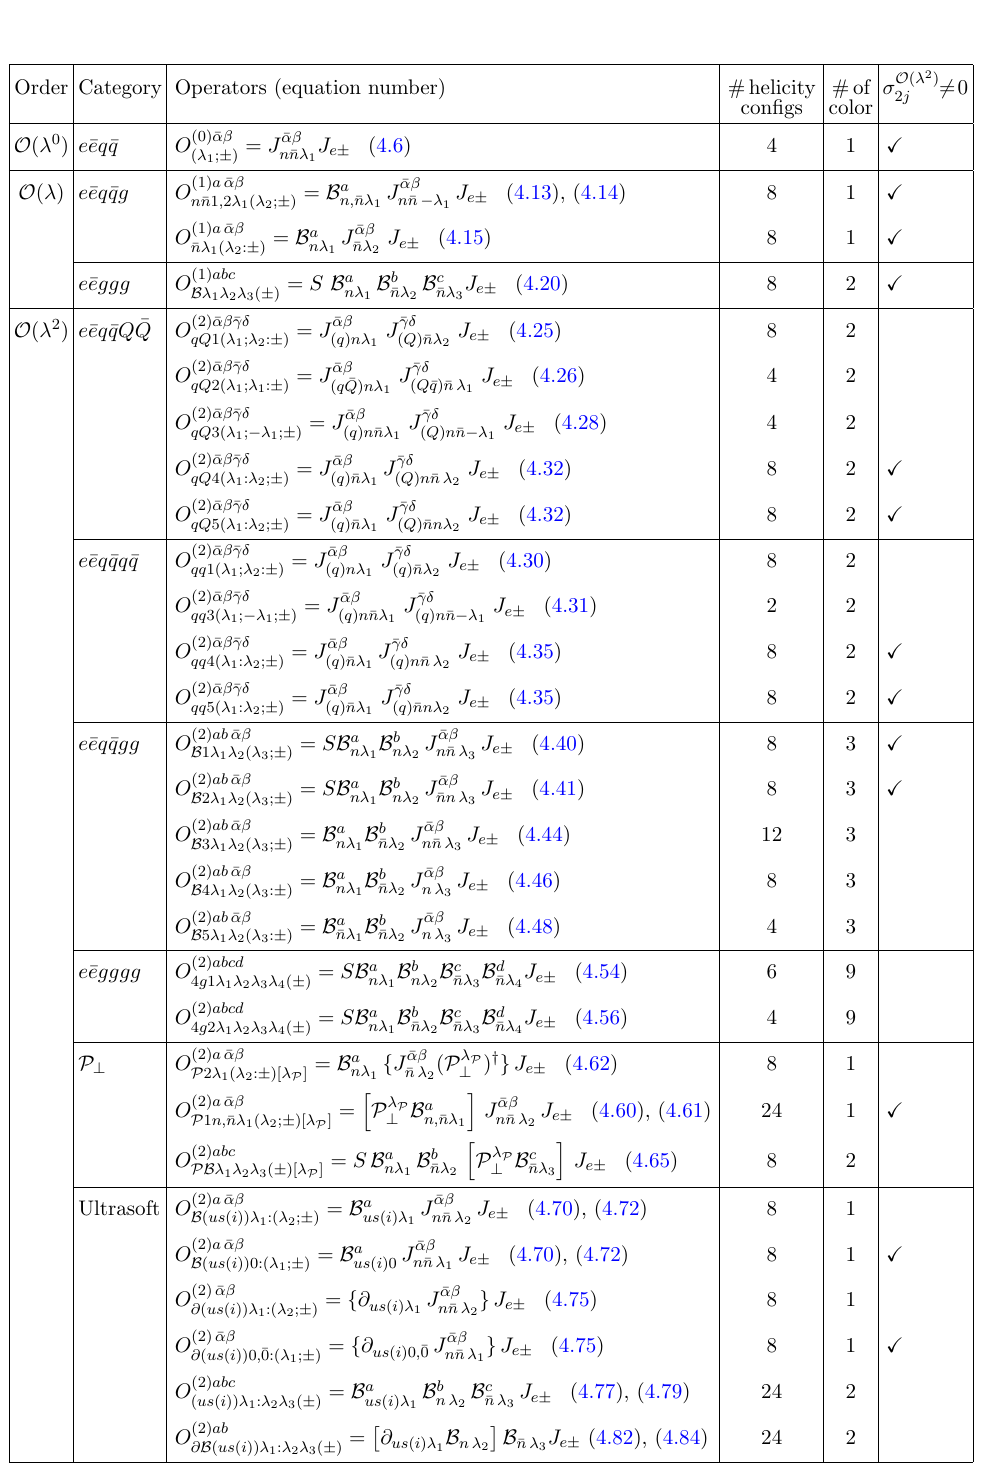
Table 4. Basis of hard scattering operators to O ( (cid:21) 2 ) with an electron current J e (cid:6) and two back- to-back collinear sectors. Here the (cid:21) i denote helicities, S represents a symmetry factor, and B a indicates B a or B a . The allowed values for the (cid:21) i helicities are given in the indicated equation, n(cid:21) 1 (cid:22) n(cid:21) 1 and the total count is given in the indicated column. The last column indicates which operators can contribute to e + e (cid:0) ! dijet event shapes and other two-direction processes up to O ( (cid:21) 2 ) in the power expansion and at any order in (cid:11) s , as discussed in detail in section